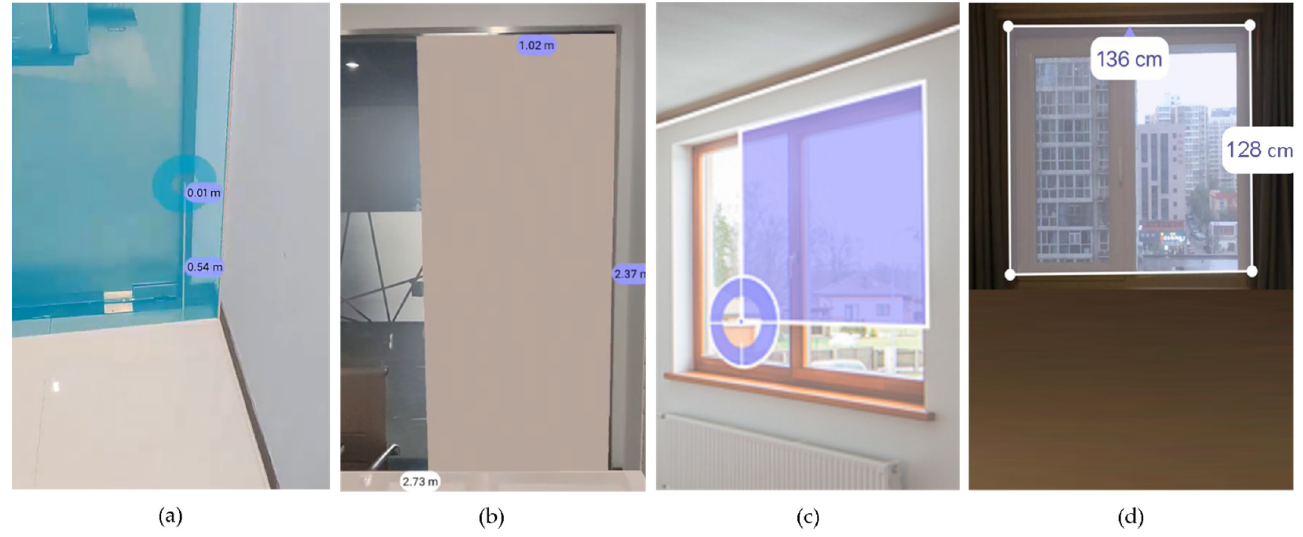
Figure 14. Capture of interior building doors and window based on 3D-GIS Semantic Constraints: ( a ) gate snapping based on 3D-GIS semantics; ( b ) the result of gate snapping, ( c ) window snapping based on 3D-GIS semantics; ( d ) the result of window snapping.